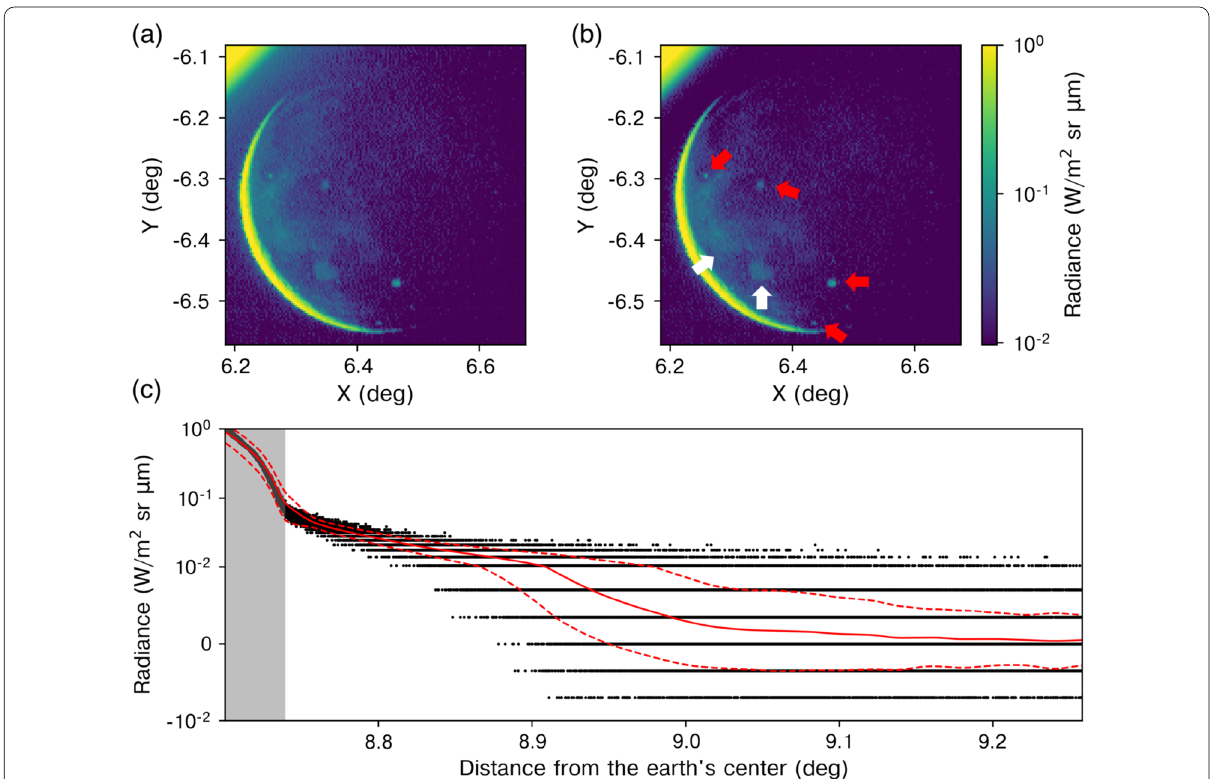
Fig. 3 The lunar images taken at band 14 on 2015/11/09 13:10 a before and b after the extraction of the broad PSF from the Earth. The red arrows in b indicate bright spots corresponding to Aristarchus, Copernicus, Tycho, and Zucchius craters in order from the top. The areas indicated by the left and right white arrows in b are Oceanus Procellarum and Mare Humorum, respectively. c The broad PSF from the Earth as a function of the distance from the terrestrial center. The black dots are the pixels located outside two lunar radii. The solid and dashed red lines are the average and plus-minus one standard deviation range of the broad PSF, respectively. The left terminator is the rim of the Earth. The gray area is affected by the terrestrial